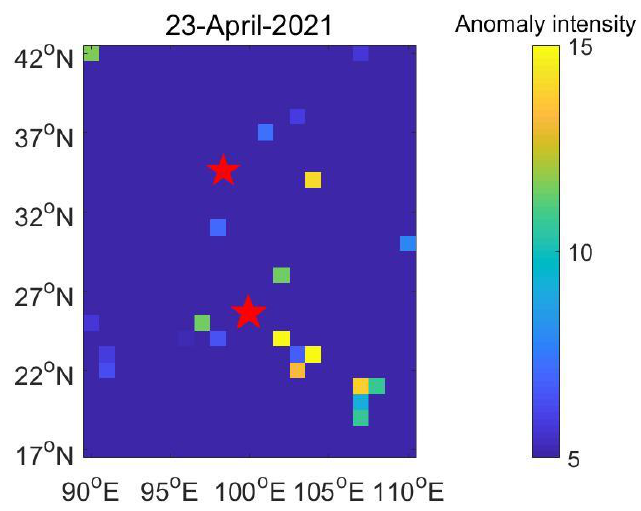
Figure 17. The relative power spectrum on 23 April 2021.